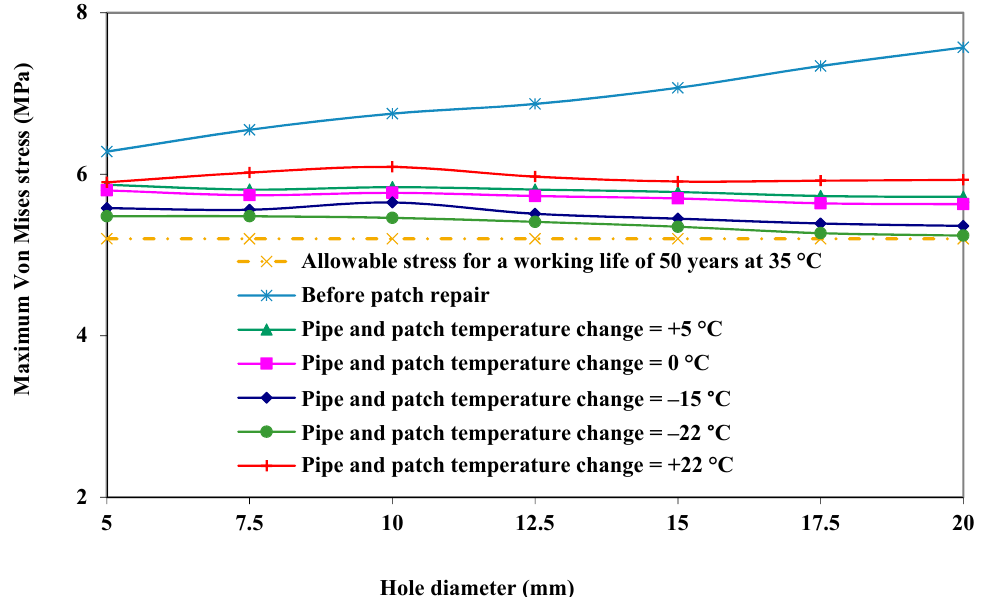
Figure 13. Maximum Von Mises stress variations in the buried pipe for various size circular hole defects repaired by circular partial patch (the simultaneous effect of soil load, internal pressure, vehicle wheel load and temperature variations).